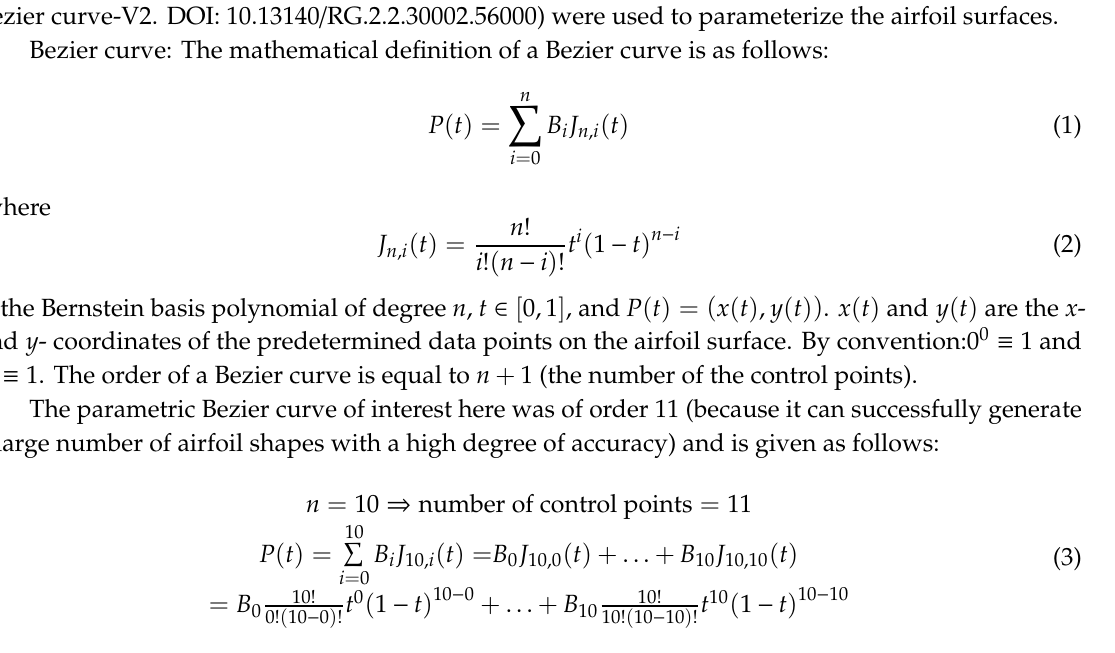
(Figure 2). The airfoil chord was divided into